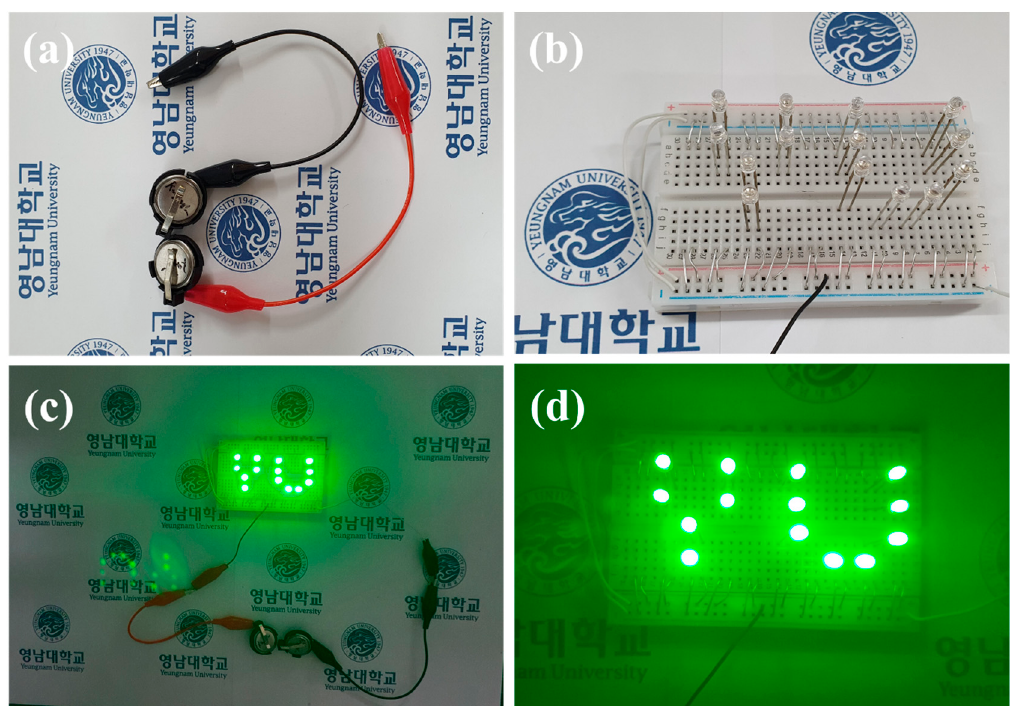
Figure 11. ( a ) Two HSC cells connected in series to light green LEDS, ( b ) YU pattern made up of 14 LEDs, ( c , d ) 14 LEDs powered by two serially connected HSC cells.